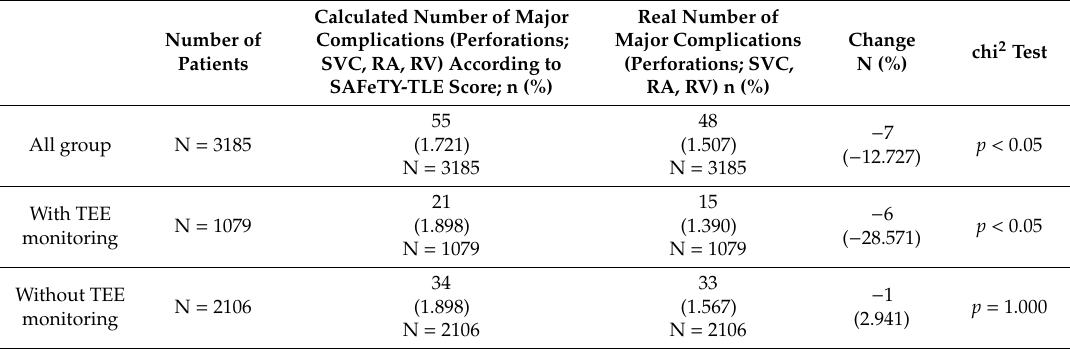
Table 6. Comparison of number of major complications (perforations; SVC, RA, RV), calculated vs real complications, according to data from Tables 4 and 5. Calculated Number of Major Real Number of Number of Complications (Perforations; Major Complications Change chi 2 Patients SVC, RA, RV) According to (Perforations; SVC, N (%) SAFeTY-TLE Score; n (%) RA, RV) n (%) 1